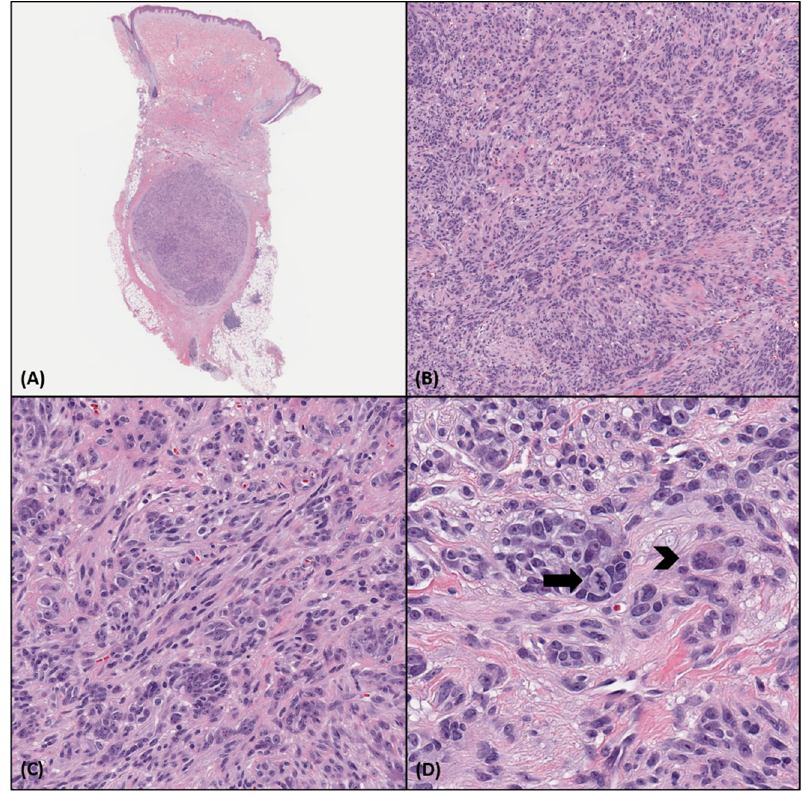
Figure 1. Histopathologic characteristics of a CMTCT case. ( A ). Punch biopsy specimen showing a well-circumscribed encapsulated nodule in the deep dermis and subcutis. (H&E, 10×) ( B , C ). The tumor is predominantly arranged in nests and bundles that are surrounded by thin collagenous fibers. It is composed of relatively uniform epithelioid and spindle cells with eosinophilic cytoplasm and round to oval nuclei with prominent nucleoli. (H&E, 100×, 200×) ( D ). A mitotic figure (black arrow) and a multinucleated cell (black arrowhead) are noted. (H&E, 400×).